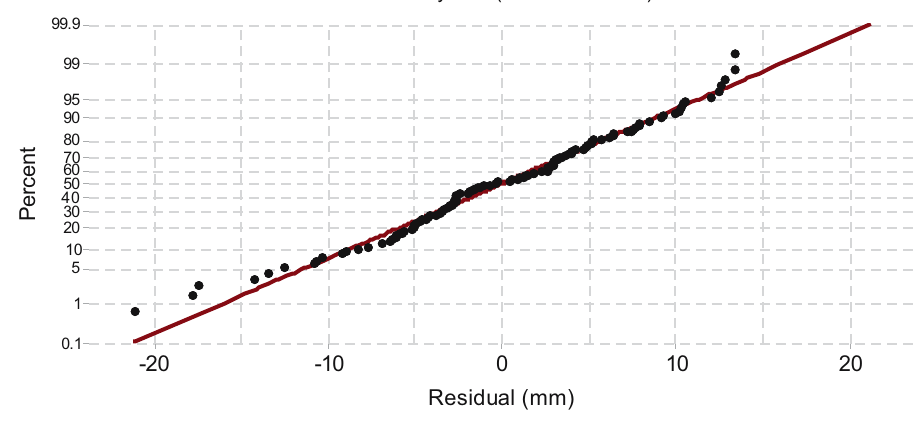
Figure 11: Misclosure residuals ( mm ) vs expected normal distribution ( red )